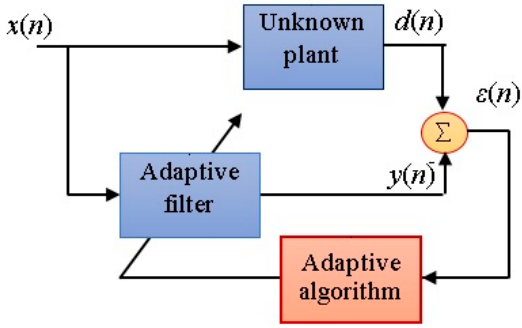
Figure 14. System identification block diagram. Table 1. Simulation results of FIR adaptation (white signal).